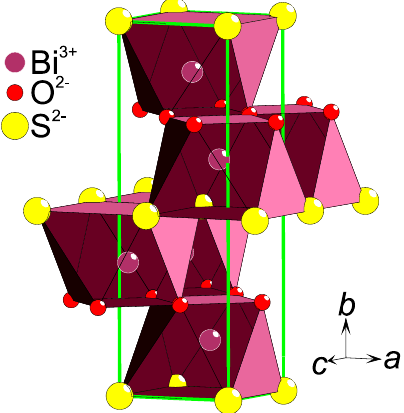
Figure 1. A part of the Bi 2 SO 2 [13] crystal structure is shown as an example of a layered anion ordering. The heteroleptic coordination of Bi is emphasized with a polyhedron and the unit cell is drawn with green lines.